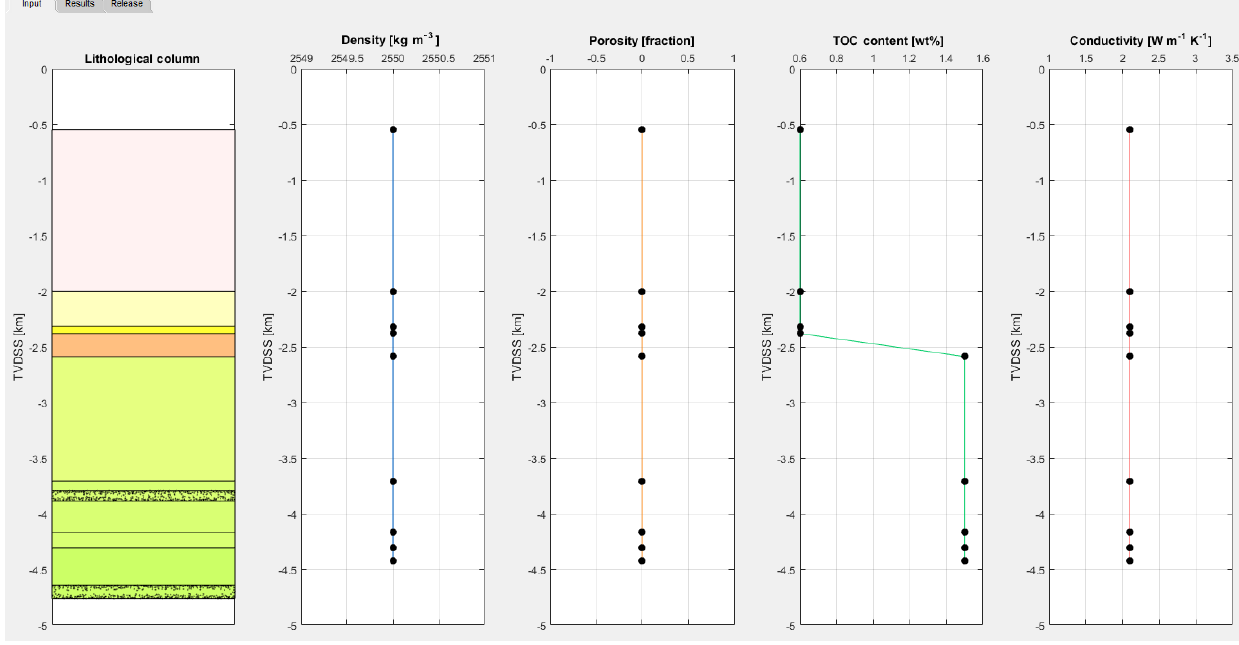
Figure 5. Input tab for the Utgard High example.